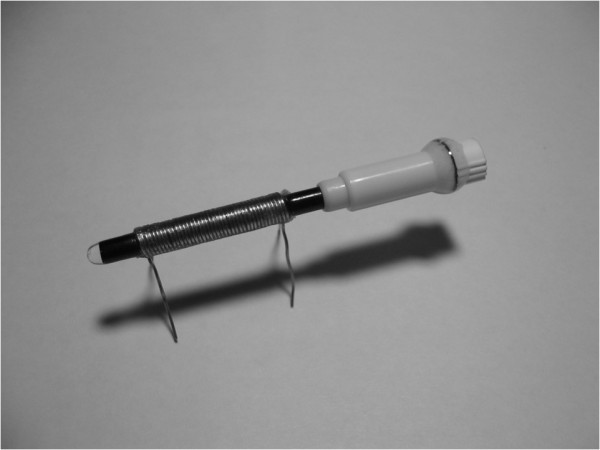
The transformer on a capillary that loads the oil-based Fe3O4 nanofluid.